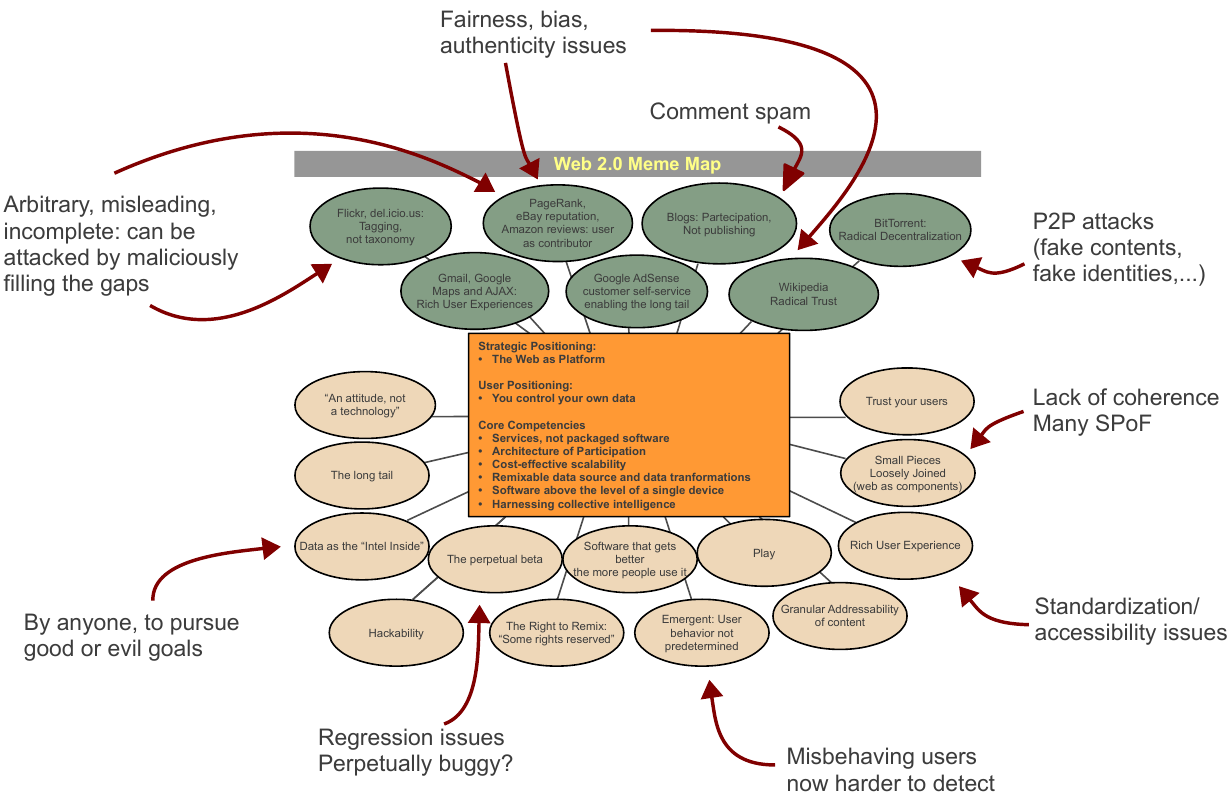
Figure 1. The original “What Is Web 2.0: Design Patterns and Business Models for the Next Generation of Software” (by Tim O’Reilly, c (cid:13) 2005 O’Reilly Media, Inc., [2]) surrounded by the vulnerabilities introduced by the new